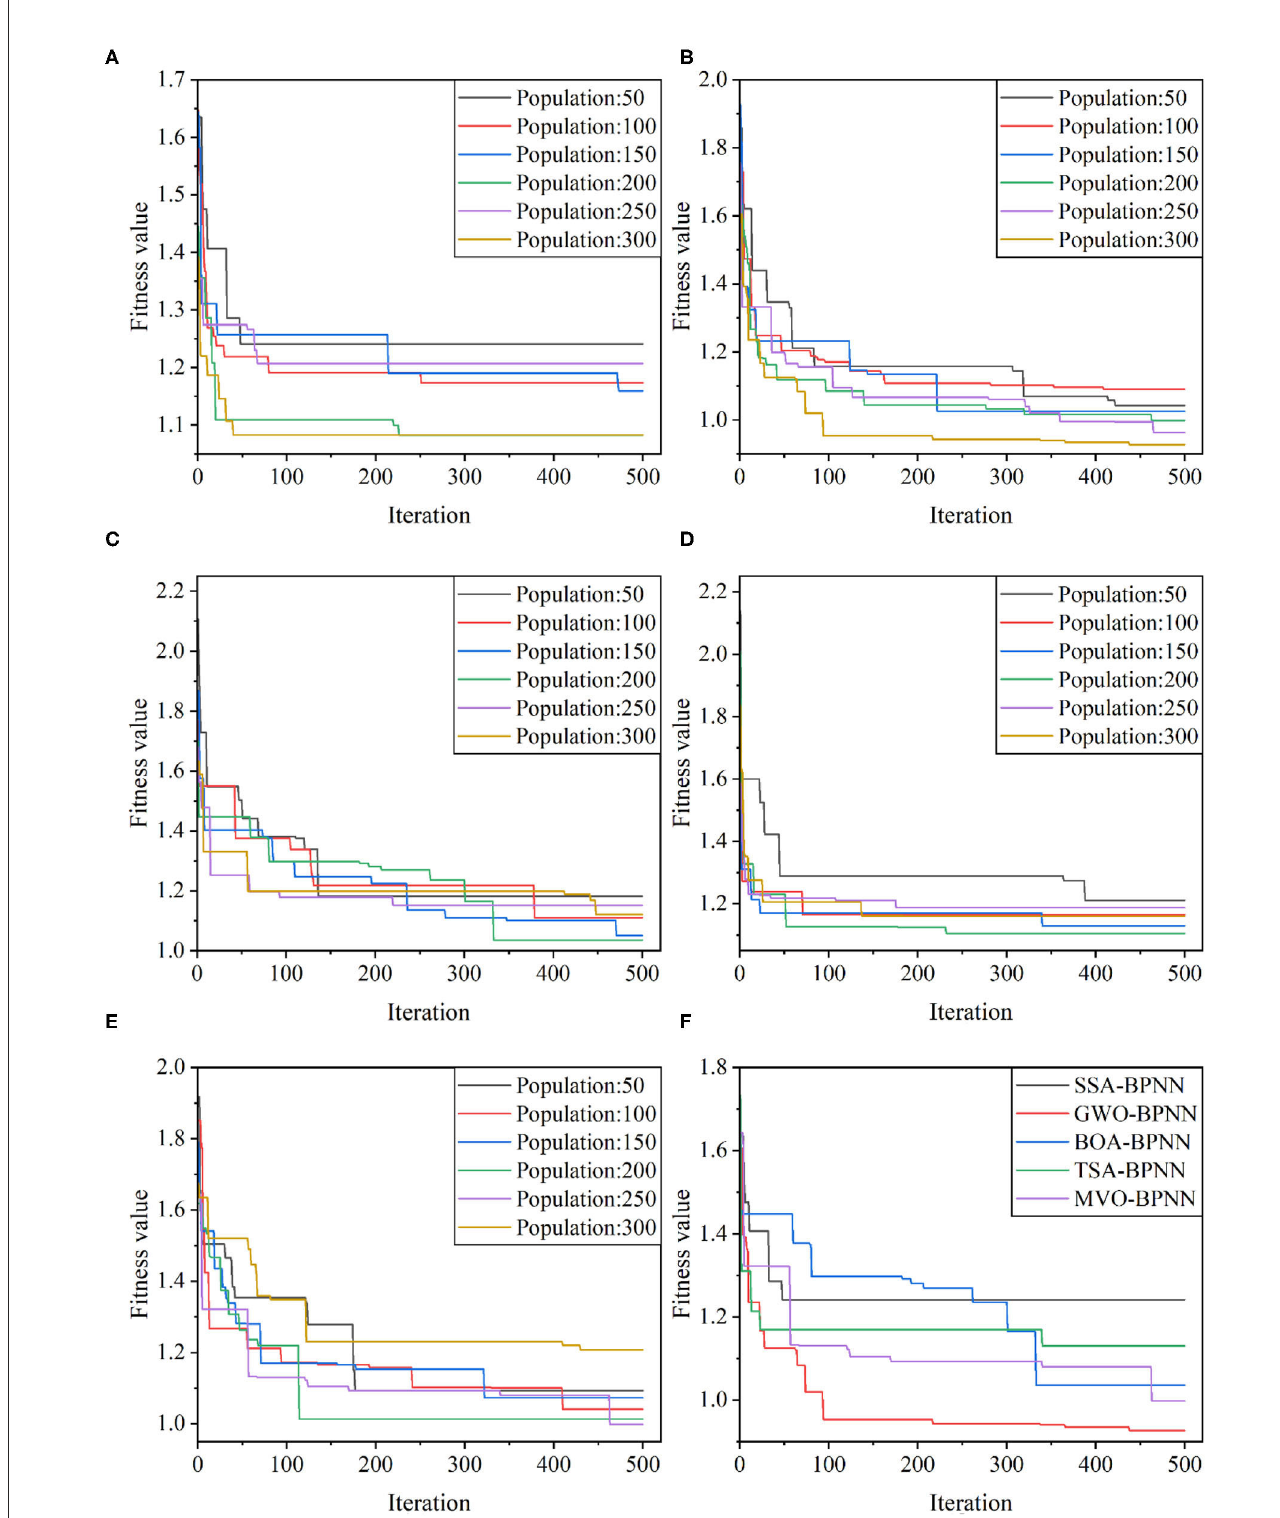
FIGURE6 Changes in the fitness values of hybrid models: (A) SSA-BP; (B) GWO-BP; (C) BOA-BP; (D) TSA-BP; (E) MVO-BP; (F) the fitness values of five different optimal population size models.